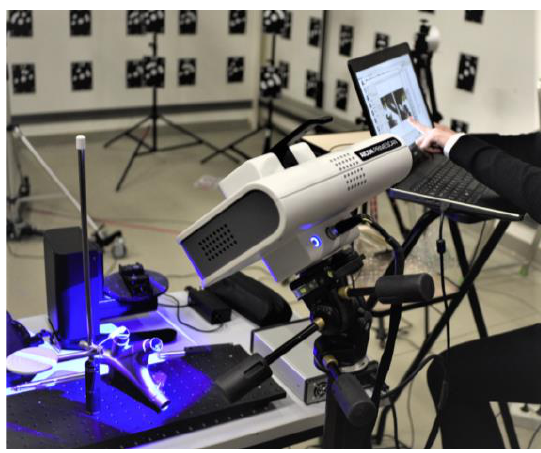
Figure 8. Acquisition of reference data on a metallic industrial object with the Aicon/Hexagon Primescan sensor.